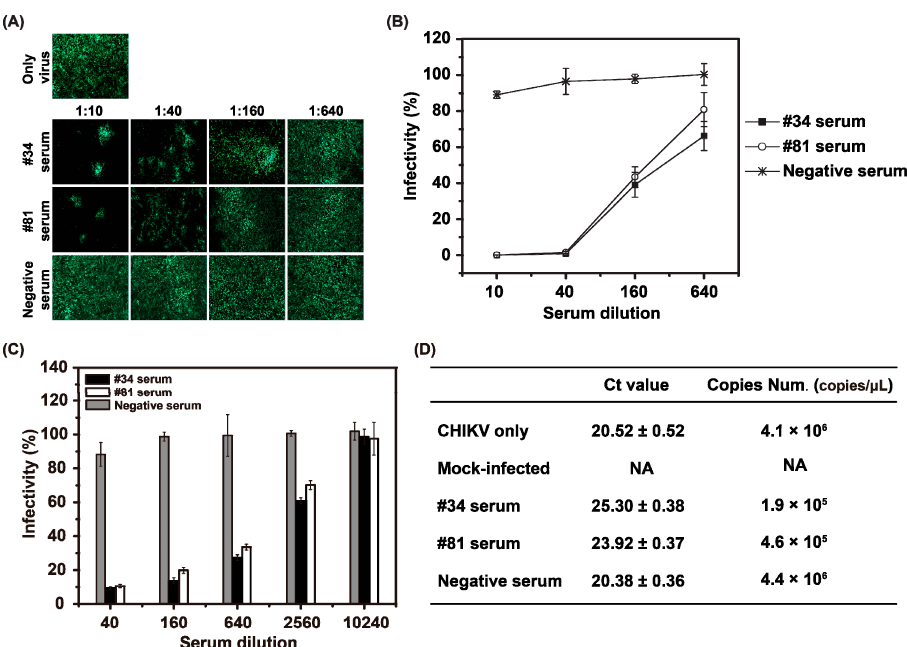
Figure 6. Confirmation of the availability of eGFP-CHIKV in neutralization assay with the serum samples from CHIKV-infected patients. ( a ) detection of eGFP expression by fluorescent microscope with different dilutions of human sera. The neutralization assay was performed in a 12-well plate. Serially 4-fold diluted human sera were incubated with eGFP-CHIKV at an MOI of 0.05 for 1 h at 37 °C before adding the mixture to the monolayer of BHK-21 cells in the 24-well plates. The readout of eGFP expression was recorded at 48 hpi. The serum from health person was used as a negative control; ( b ) quantification of neutralization assay with increasing serum dilution. The percentage inhibition of infectivity was normalized to eGFP-CHIKV infection without serum incubation by quantification of eGFP expression levels; ( c ) neutralizing activity of the human sera against WT CHIKV based on PRNT assay. WT CHIKV was incubated with 4-fold dilutions of individual sera before infecting BHK-21 cells. The percentage inhibition of infectivity for each dilution was normalized to WT CHIKV infection alone by counting the number of plaque forming units (PFU); ( d ) detection of CHIKV genome copy number in BHK-21 cells treated with virus or virus-antiserum mixture by real-time RT-PCR. The results are positive if Ct value ≤ 34, otherwise negative if Ct value >34. The genome copy numbers of #34 and #81 were significantly decreased than those of control samples ( t -test, p < 0.05). CHIKV only = BHK-21 cells were infected by WT CHIKV without serum incubation; mock-infected = BHK-21 cells were neither infected by WT CHIKV nor incubated with serum; NA = data not available. All experiments were performed in triplicate, and the representative data were presented.